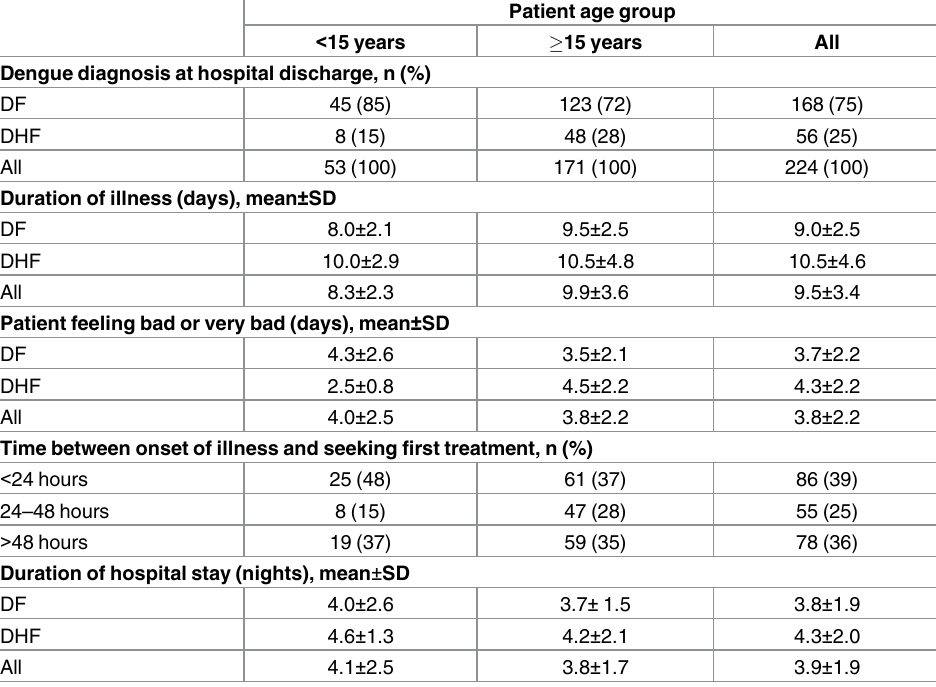
Table 2. General characteristics of the hospitalized dengue cases by patient age group and disease severity,Chacheongsao province, Thailand, 2015.